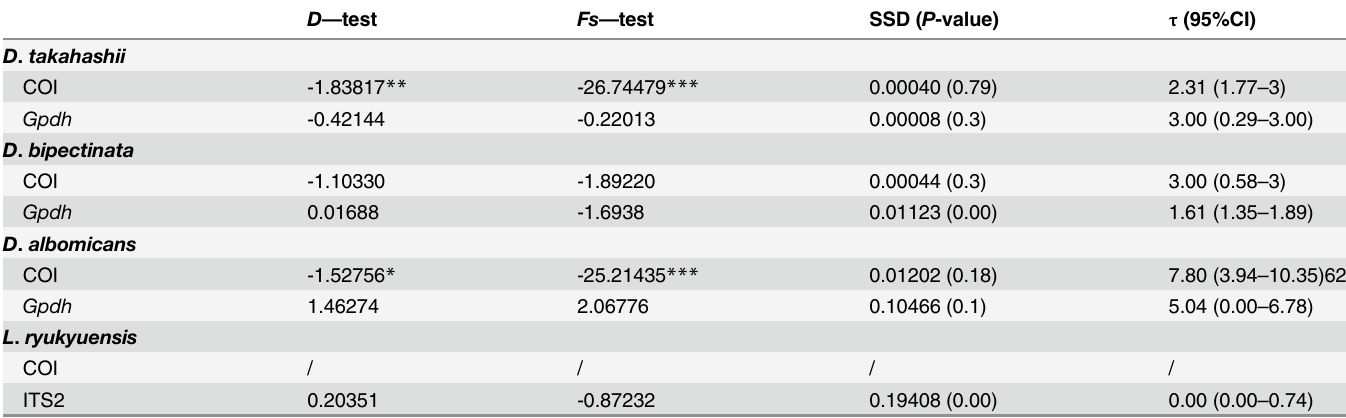
Table 2. Summary of historical demographic expansion analyses for Drosophila takahashii , D . bipectinata , D . albomicans , and L . ryukyuensis